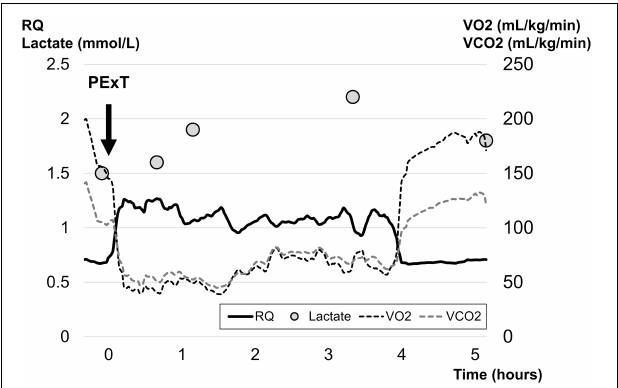
FIGURE 1 | Changes in expired gas parameters and blood lactate over time. The trends of gas exchange measurements and blood lactate are presented. Ten minutes after the first PExT, both VO 2 and VCO 2 suddenly dropped, while RQ began to rise steeply before a rise in the level of blood lactate level up to 2.2 mmol/L a few hours after the RQ elevation. All of these parameters plateaued over the next 4 h, and then returned to the initial level. PExT, partial exchange transfusion; RQ, respiratory quotient; VCO 2 , carbon dioxide production; VO 2 , oxygen uptake.